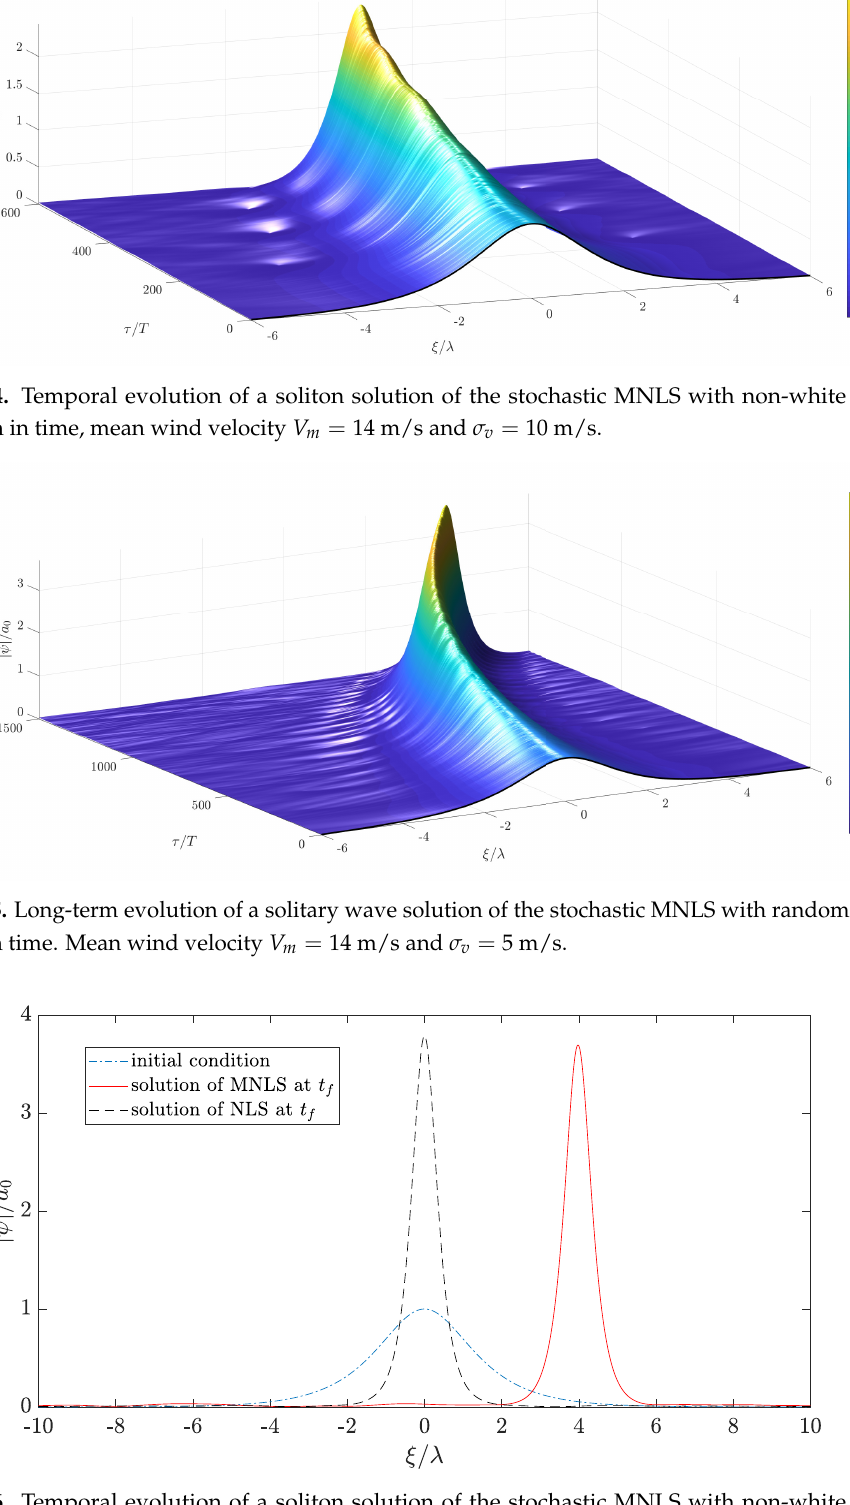
Figure 16. Temporal evolution of a soliton solution of the stochastic MNLS with non-white noise excitation in time, mean wind velocity V m = 14 m/s and σ v = 10